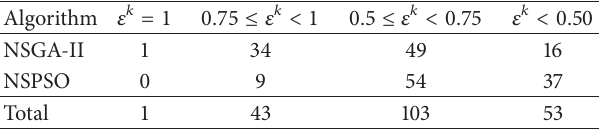
Table 4: Percentage of solutions obtained.